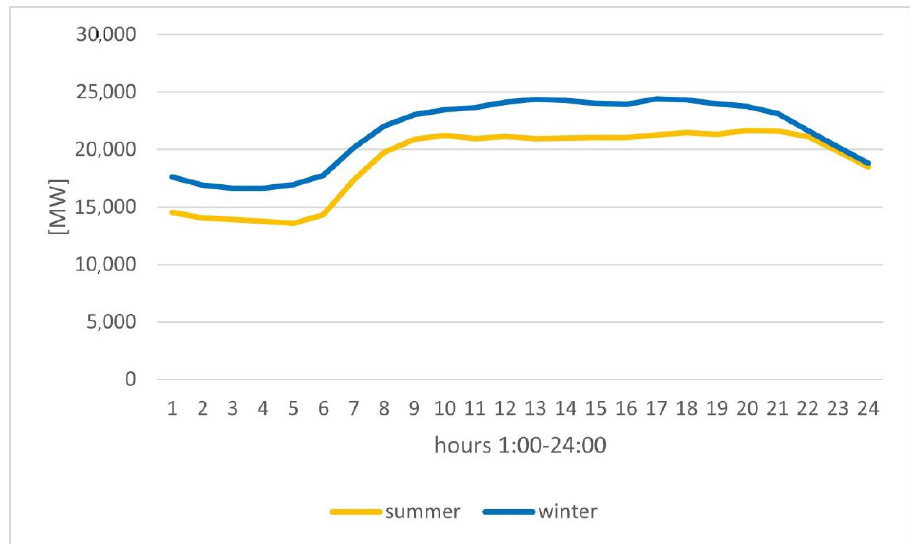
Figure 3. Daily energy consumption in the summer and winter period in 2022. Source: own elaboration based on data from [53].